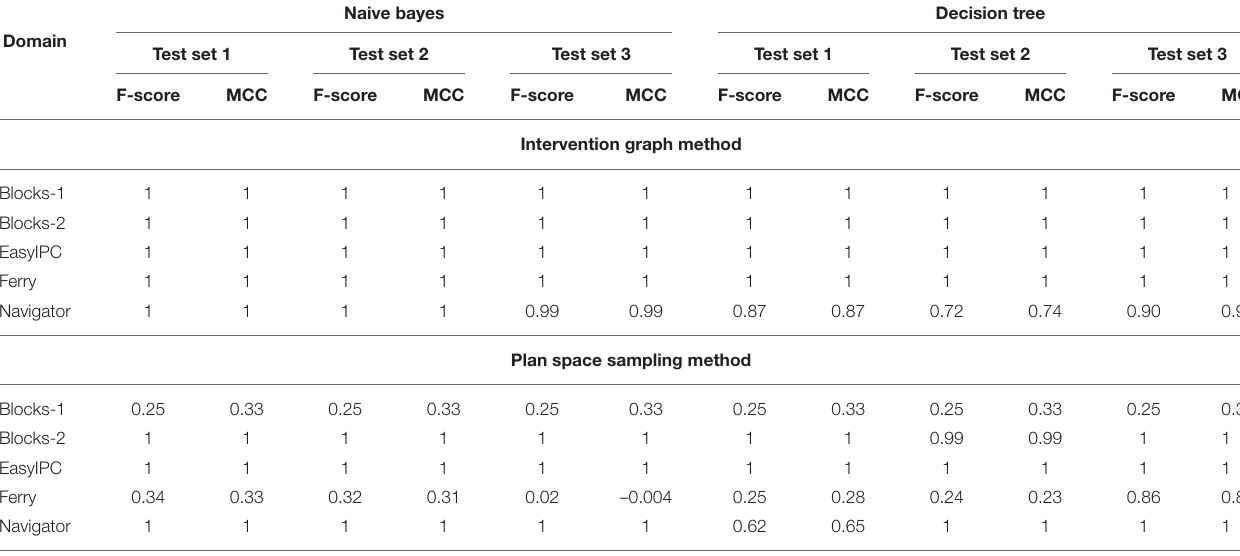
TABLE 3 | F-score and MCC for predicting intervention using Intervention Graph and the Plan Space Sampling methods for Naive Bayes and Decision Tree classifiers.